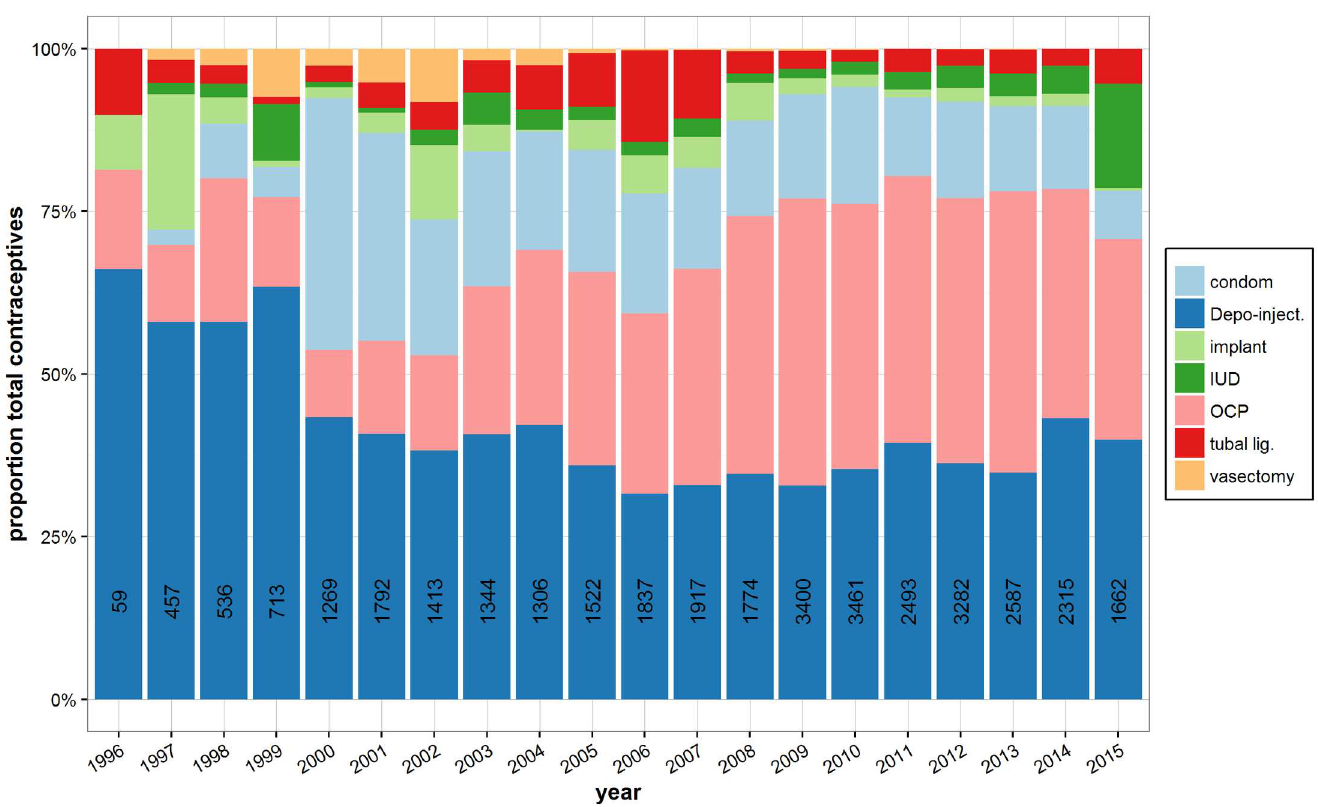
Fig 2. Composition of total recorded new contraceptive consultations by contraceptive type and year. The total number of new consultations per year is indicatedin each bar. There was a transition in most reproductive health services from SMRU to PPAT in 2000. The increaseproportion attributableto tubal ligation(“tubal lig.”) in 2005–2006coincideswith SMRU hiring a local surgeonwho could offer the service